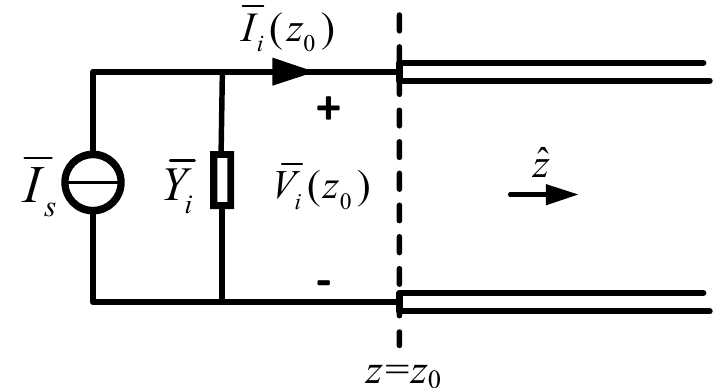
Figure 2. Equivalent modal excitation circuit for the WLTL.